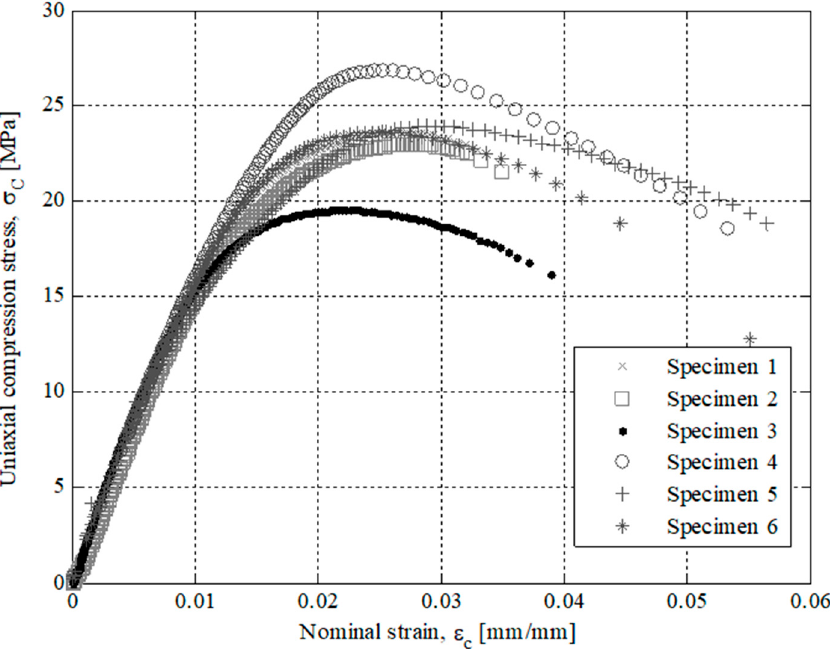
Figure 9. Curves for Z Axis manufactured specimens related to uniaxial compression stress versus nominal strains.